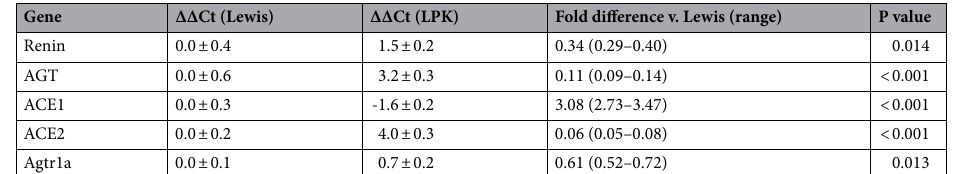
Table 1. Fold difference in kidney RAS gene expression between Lewis and Lewis Polycystic Kidney (LPK) rats at 10 weeks of age. RAS renin-angiotensin system, AGT angiotensinogen, ACE angiotensin-converting enzyme, Agtr1a angiotensin type 1a receptor. Data are presented as ΔΔCt with the Lewis animals used as the reference group. Fold difference (range) was calculated using the 2 −(ΔΔCt ± Standard Error (SE) of the ΔCt) method.